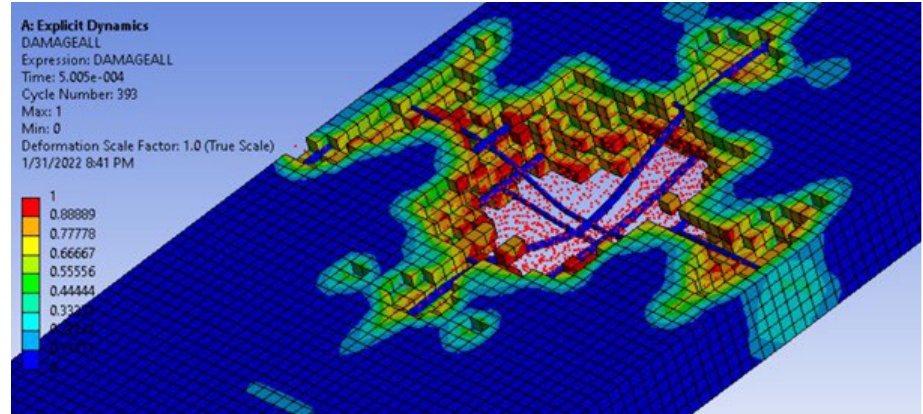
Figure 13 Deformation and steel buckling at mid of UHPC-7 Slab